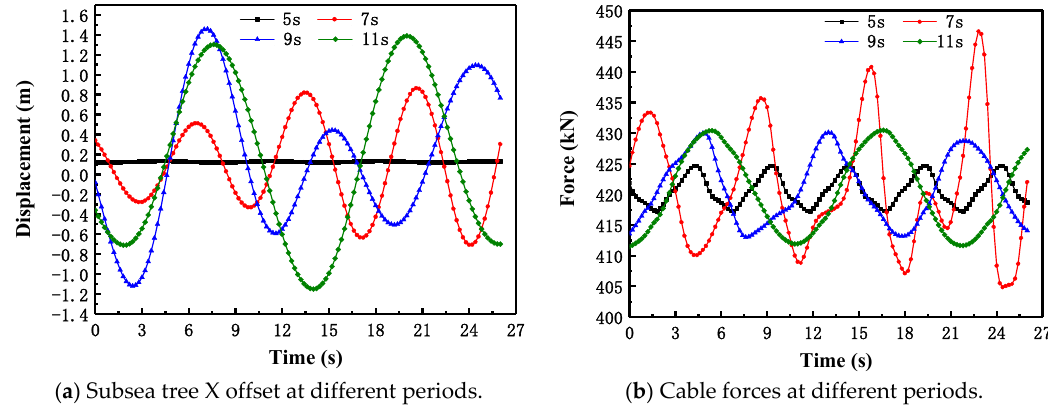
( b ) Cable forces at different periods. Figure 10. Subsea tree offset and cable forces at different periods.